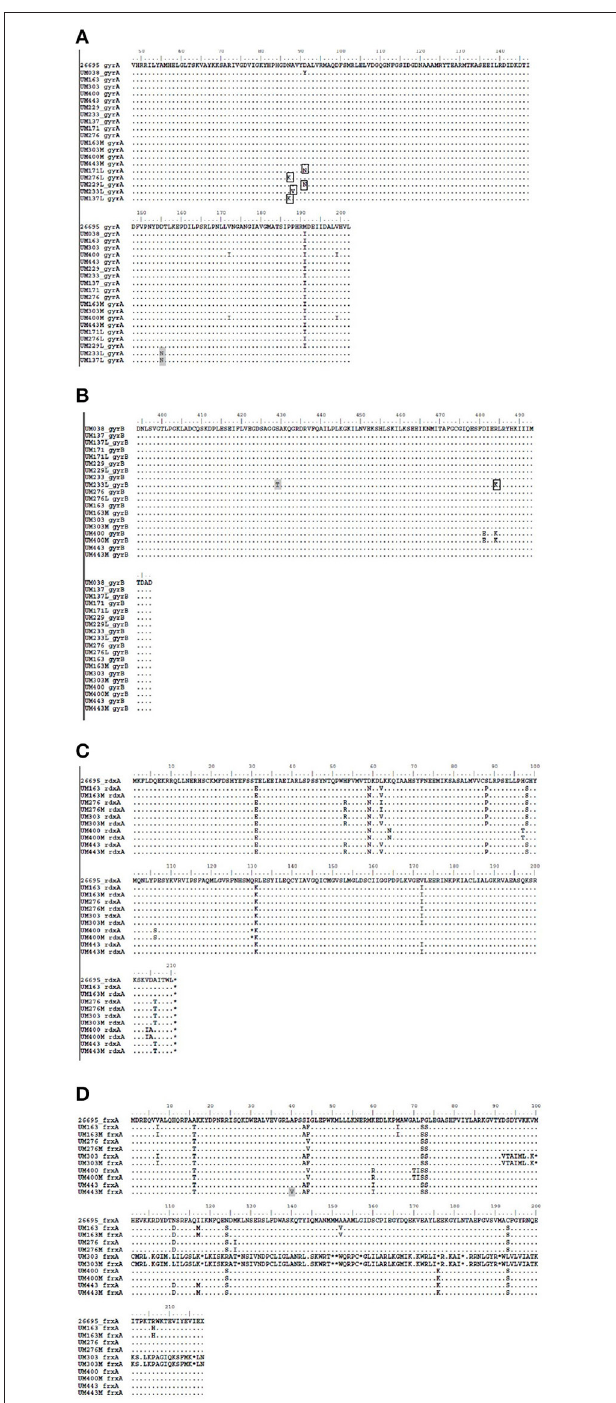
FIGURE 4 | Amino acid sequences of levofloxacin resistance-associated gene regions: (A) gyrA, (B) gyrB , and metronidazole resistance-associated gene regions: (C) rdxA, (D) frxA of H. pylori strains. gyrA and gyrB sequences were compared to UM038 strain (positive gyrA mutation), and rdxA and frxA sequences were compared to a reference strain, 26695. Positions of expected mutations associated with levofloxacin are in box outlines, and positions of variations of mutation in either antibiotic-resistant strains are in gray